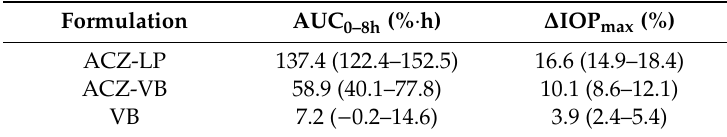
Table 4. Stage one: mean values of area under the ∆ IOP-time curve and the ∆ IOP max of each treatment (90% confidence